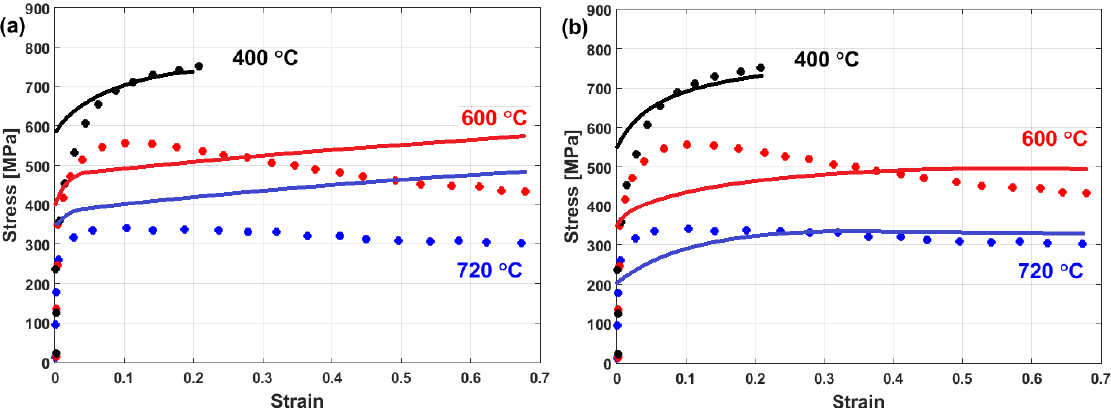
Figure 53. Comparison between experimental stresses (markers) and predicted stresses (solid lines) for C45 steel alloy obtained by ( a ) the original JC model and ( b ) the modified JC model that was presented by Priest et al.